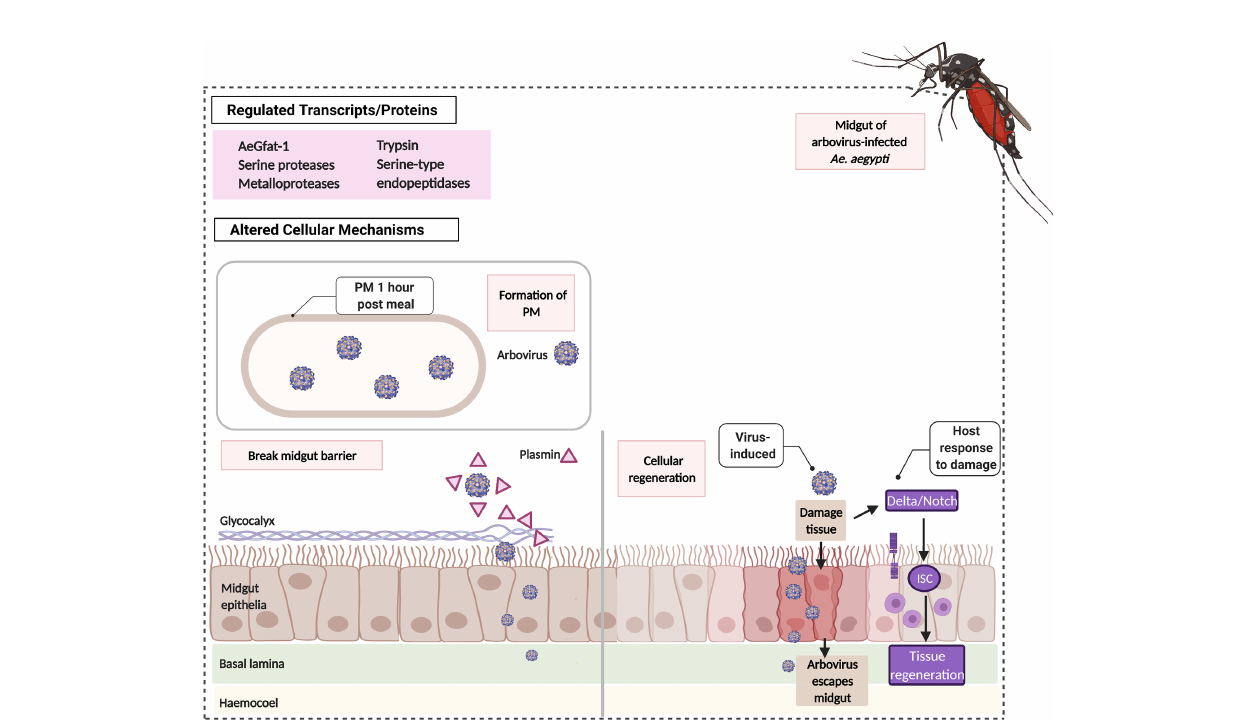
FIGURE 2 | Arboviruses induce the formation of PM, cleaving of protective layer and Delta/Notch in Ae. aegypti ’ s midgut. An hour from the ingestion of virus- infected blood meal, Ae. aegypti forms a thick peritrophic membrane (PM) that encloses the virus separating it from the midgut epithelia. This PM prevents the virus from escaping the midgut and spreading the infection. Arboviruses may utilize proteolytic enzymes e.g. plasmin to break the glycocalyx, a protective layer at the surface of the midgut epithelia. Arboviruses may also directly damage the midgut tissue. Ae. aegypti can reverse this damage by activating the Delta/Notch resulting in the proliferation of Intestinal Stem Cells (ISC) for cellular